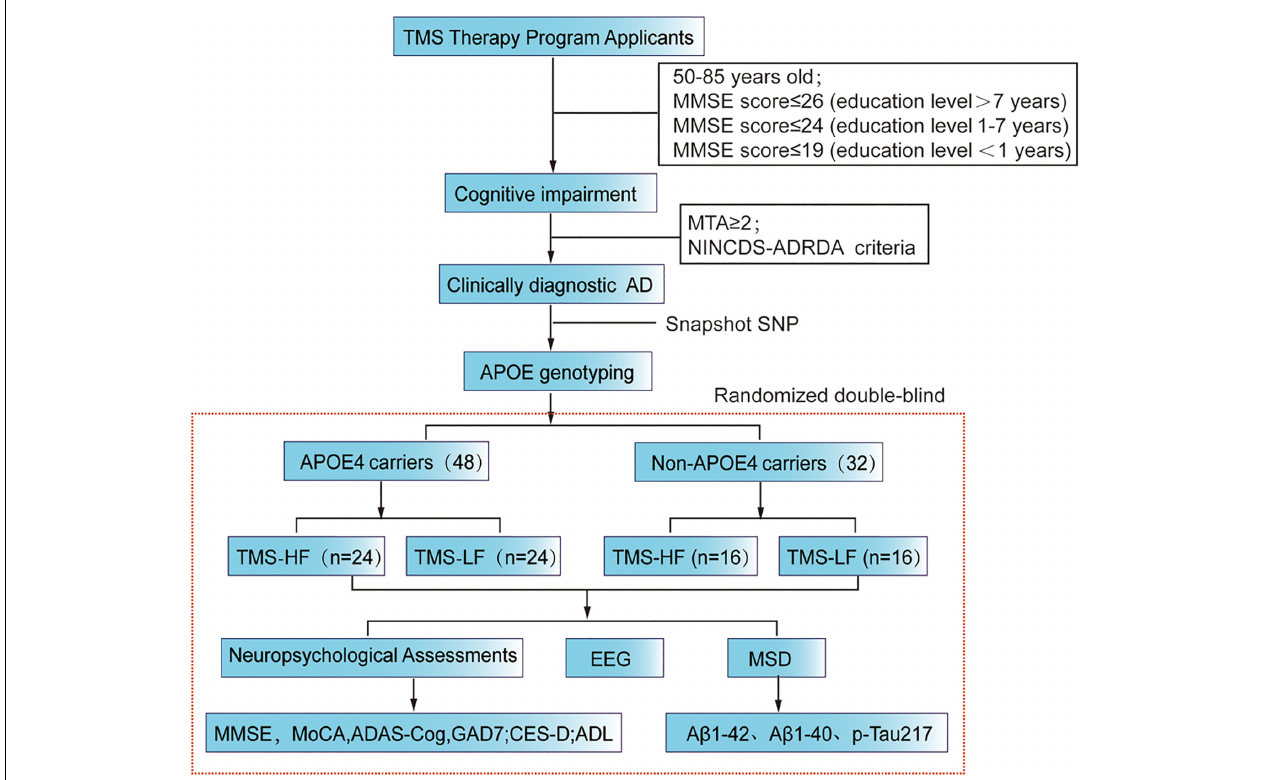
FIGURE 1 | Flow chart of the present RCT study. MMSE, Mini Mental State Examination; rTMS, repetitive transcranial magnetic stimulation; MoCA, Montreal Cognitive Assessment Scale; ADAScog, Assessment Scale-cognitive subscale; Center for Epidemiologic Studies Depression Scale (CES-D); Activity of Daily Living (ADL); MSD, Meso Scale Discovery.